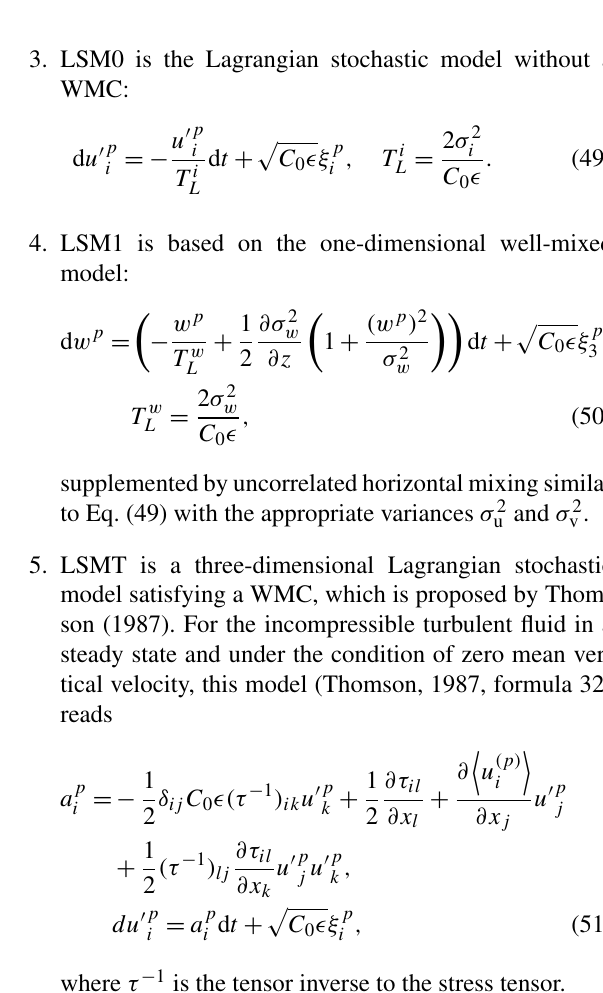
Figure 10. (a) Discrete (LES) non-dimensional dissipation (cid:15) (cid:49)k κz k / | τ | 3 / 2 (circles), corrected values (solid line), universal function (Eq. 44) (dashed straight line). (b) Simulated discrete dissipation (cid:15) (cid:49)k (circles) and corrected dissipation (cid:15) cf (z) for LSM (solid line). Dashed horizontal line denotes the height z e , which was chosen in order to equalize the integral values of the corrected dissipation and the discrete